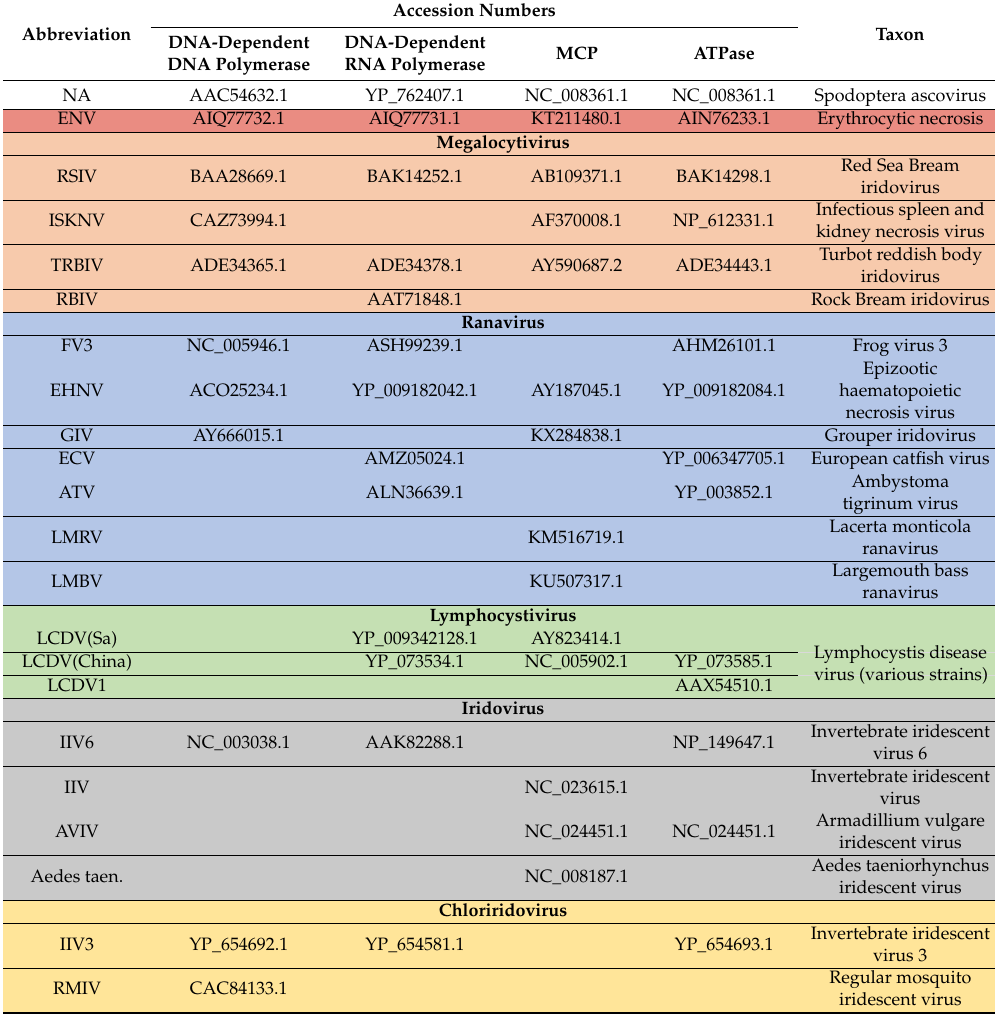
Table 2. GenBank reference sequences and viral species used to create phylogenies, with colors indicating genera groups corresponding to phylogenetic trees in Figure